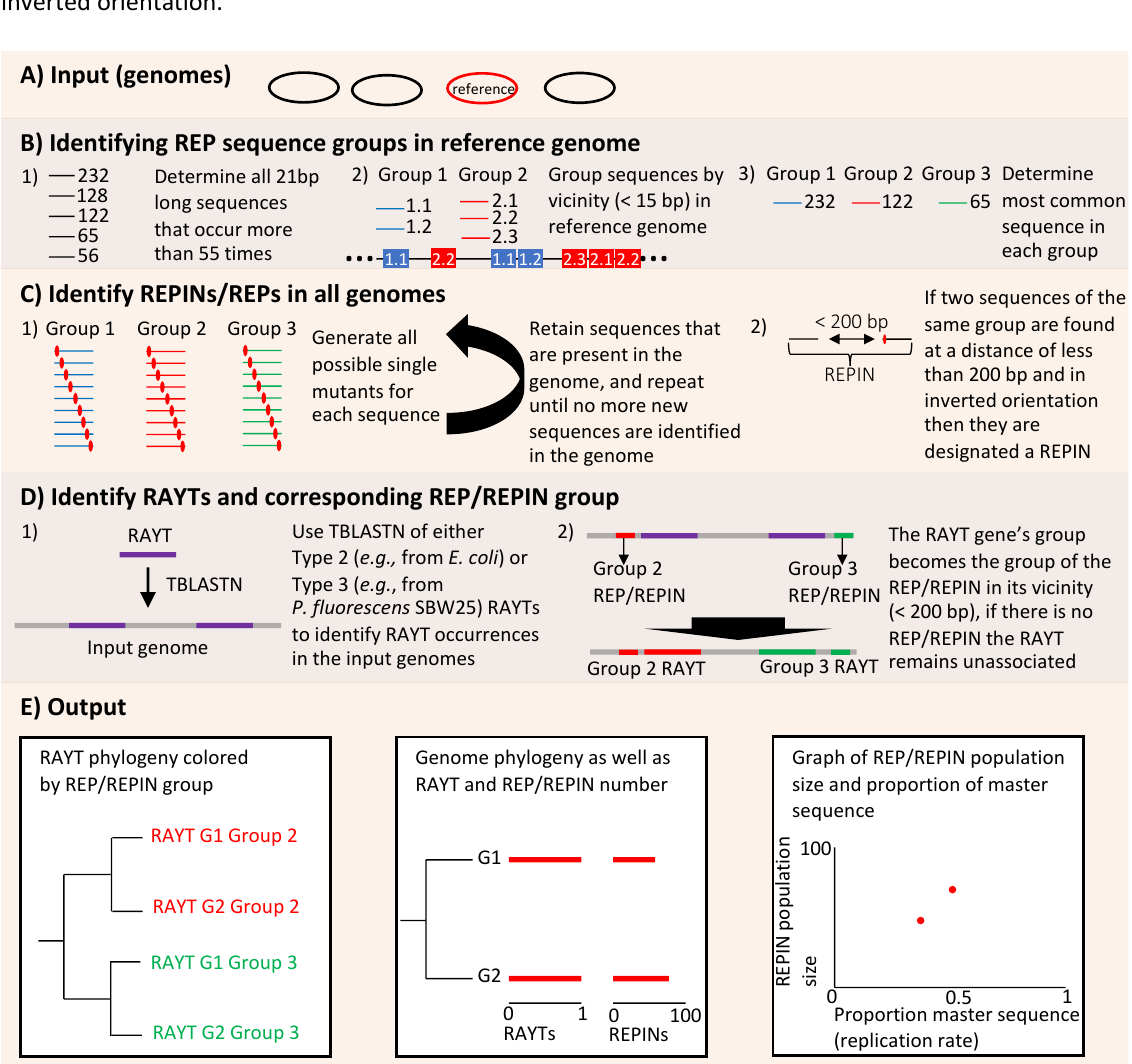
Figure 2 - RAREFAN workflow. (a) By default RAREFAN requires the user to supply input sequences containing RAYTs and REPINs. These are fully sequenced and complete genomes. ( b ) RAREFAN then identifies seed sequence groups (potential REP sequences) in the reference genome by first isolating all 21 bp (adjustable parameter) long sequences that occur more than 55 times (adjustable parameter) in the reference genome. It is likely that a large number of these sequences belong to the same REPIN sequence type since the conserved part of REPINs is longer than 21 bp. Hence, we grouped all sequences together that occur within 15 bp (adjustable parameter) of each other anywhere in the genome. All further analyses are performed only with the most common sequence in each sequence group. This sequence will be called the seed sequence. ( c ) The occurrences of the seed and mutated seed sequences are identified in all submitted genomes. If a mutated seed sequence is identified in a genome, then all single mutants of that seed sequence are searched recursively in the same genome. All identified sequences that occur within 130 bp in inverted orientation of each other are designated REPINs. All other identified seed sequences and mutated seed sequences are REP singlets. ( d ) TBLASTN is used to identify RAYT homologs (e-Value < 1e-30, adjustable parameter) of either E. coli (Group 2 RAYT) or P. fluorescens SBW25 (Group 3 RAYT) across all submitted genomes. If a RAYT homolog is in the vicinity (default < 200 bp, adjustable parameter) of a previously identified REPIN or REP singlet, then this RAYT is designated as associated with this REPIN group. ( e ) The first graph contains a RAYT phylogeny computed from a nucleotide alignment of all identified RAYT genes. The RAYT phylogeny indicates what RAYTs are associated with what REPIN populations (largest sequence cluster calculated with MCL) via colour coding. In a second graph the abundance of each REPIN population and RAYT copy number are displayed on a genome phylogeny. In the last graph REPIN population sizes are plotted in relation to the proportion of master sequences. Master sequences are the most abundant REPIN in each population. RAREFAN also generates various files containing, for example, REP, REPIN, or RAYT sequences and their positions in the query